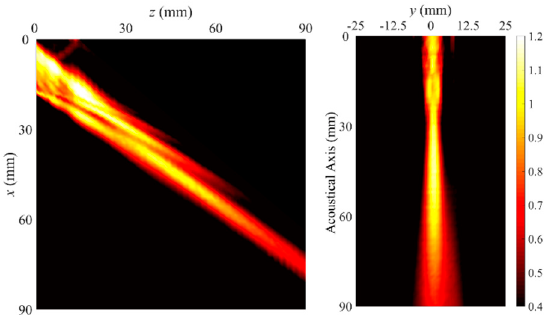
Figure 18. Measured beam profiles of the leaky Lamb wave excited at d = 350 mm (1.0 mm thickness and 15 mm width, 1.5 MHz center frequency).